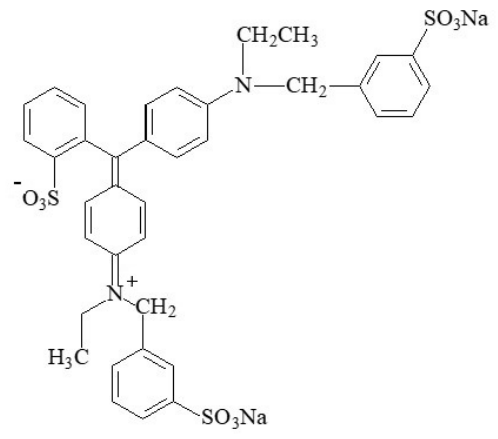
Figure 25. Structural formula of brilliant blue FCF (E133).